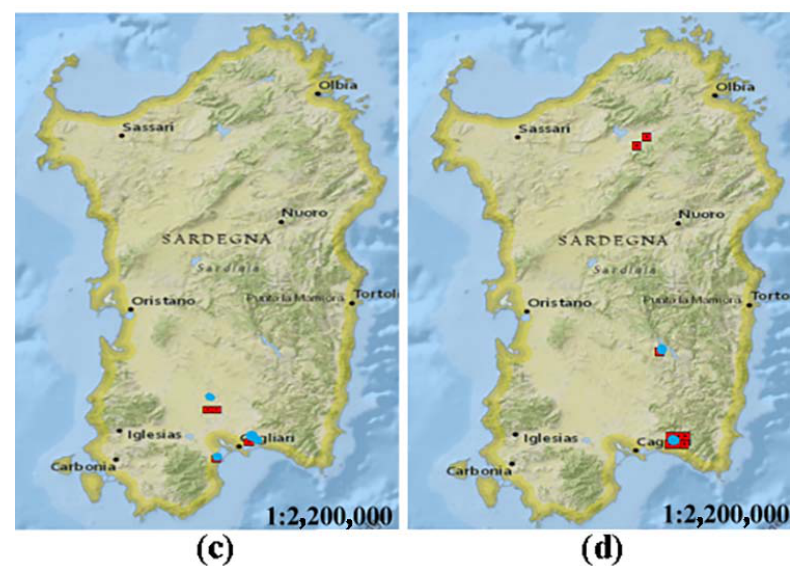
Figure 7. Comparison between SFIDE detected hot-spot and Corpo Forestale e di Vigilanza Ambientale (CFVA) measurements on 2014: 2 July ( a ); 3 July ( b ); 8 July ( c ) and 5 August ( d ).